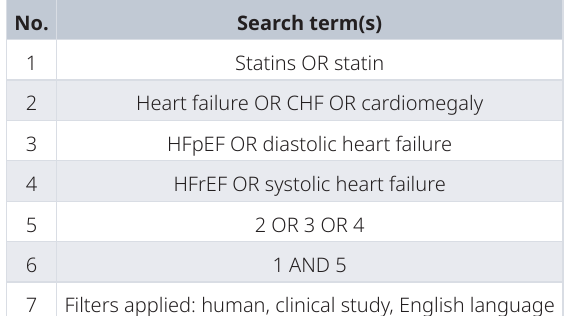
Filters applied: human, clinical study, English language